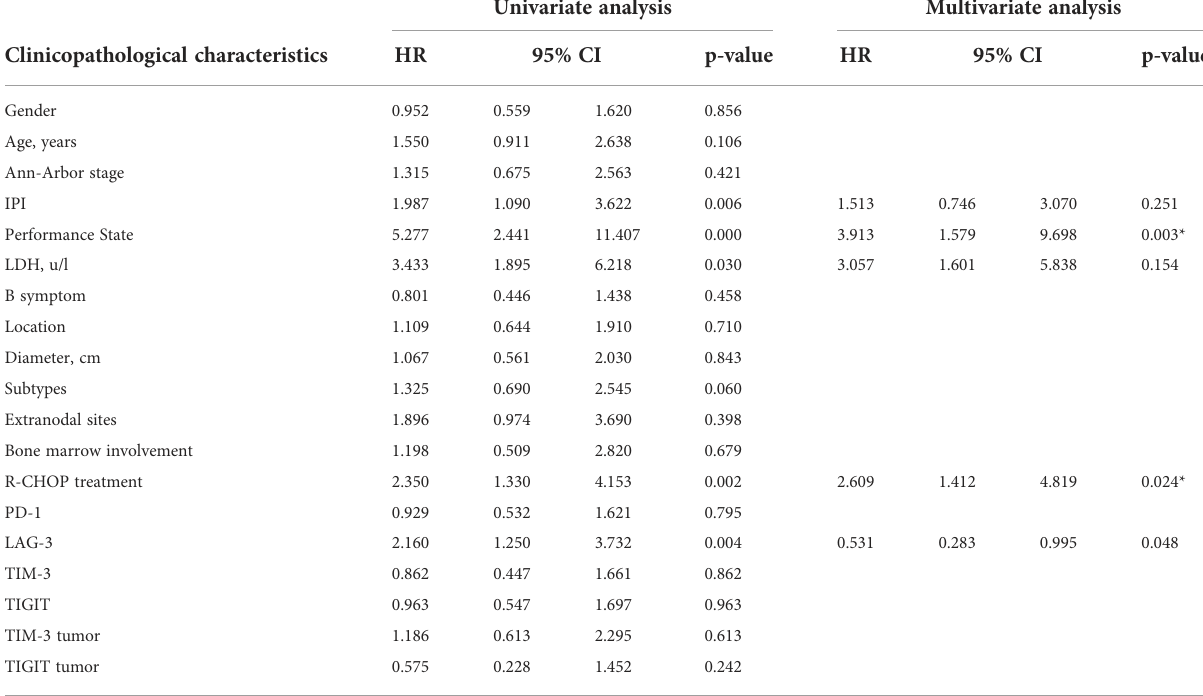
TABLE 6 Univariate and multivariate analyses of clinicopathological factors associated with progression free survival in DLBCL